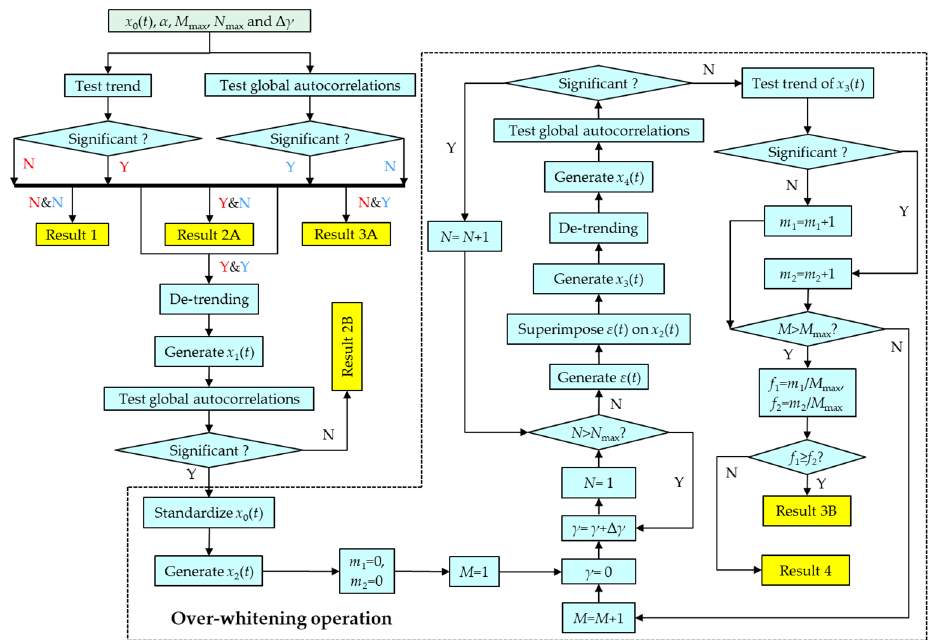
Figure 4. Trend test for HCTS based on the OW operation. (Note: x i ( t ) ( i = 1, …, 4) is the time series processed in the trend test; M denotes the current number of simulations; M max represents the maximum number of simulations; m 1 and m 2 are the numbers of occurrences of Results 3B and 4, respectively; f 1 and f 2 are the occurrence frequencies of Results 3B and 4 in many simulations, respectively; N denotes the current number of cycles of the OW operation; N max is the maximum number of cycles for the OW operation; ε ( t ) is a randomly generated white noise; γ represents the variance of ε ( t ); Δ γ denotes the increasing step of variance γ ; and other information can be found in Figure 3).